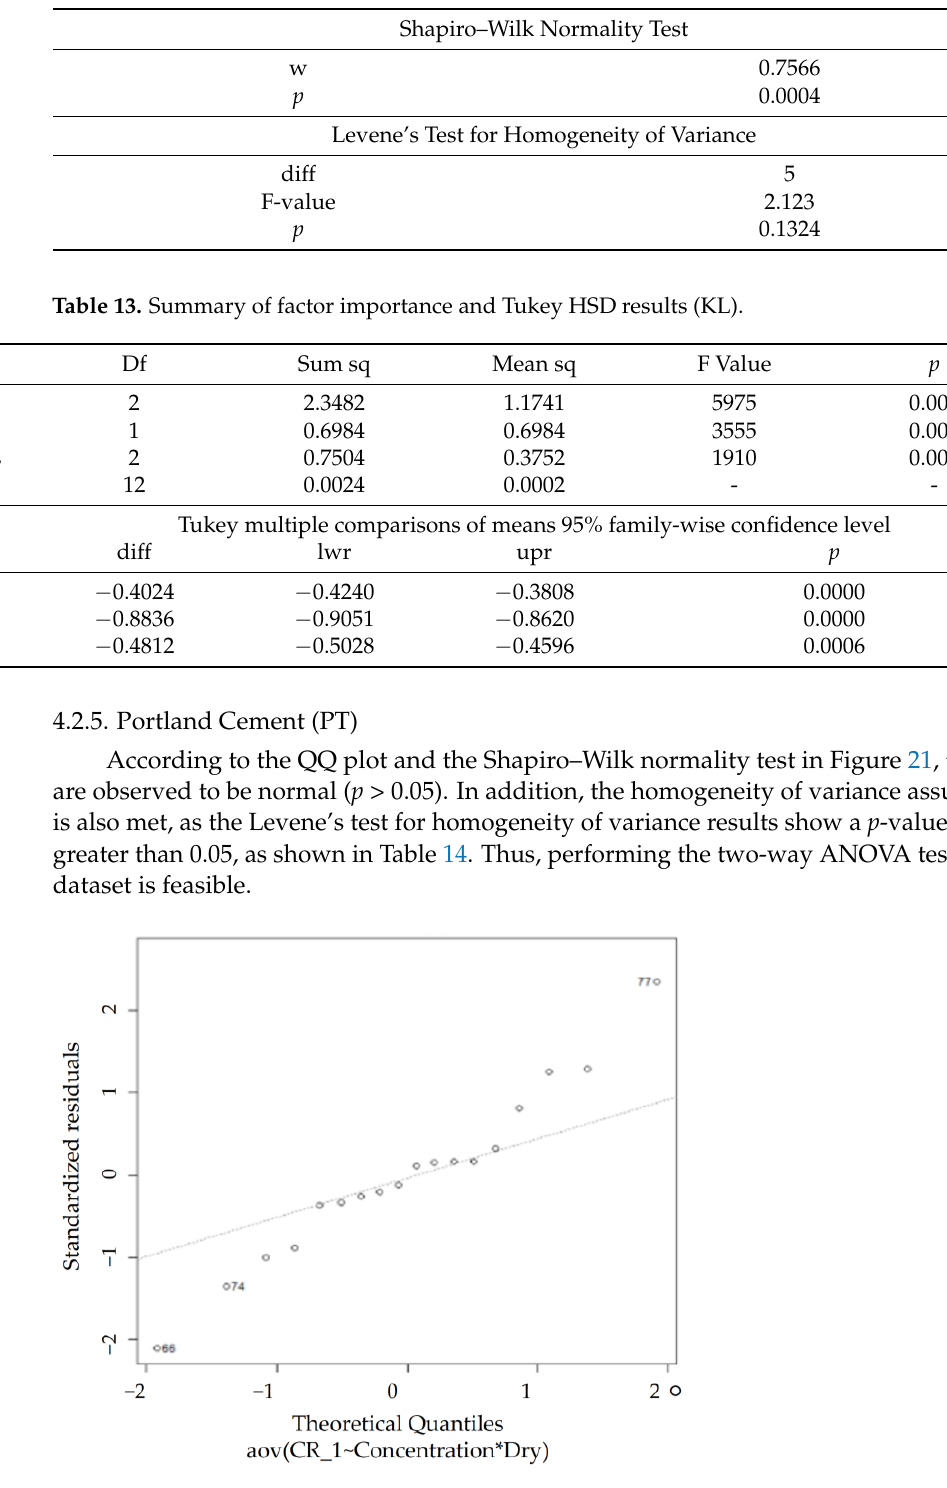
Table 13. Summary of factor importance and Tukey HSD results (KL).